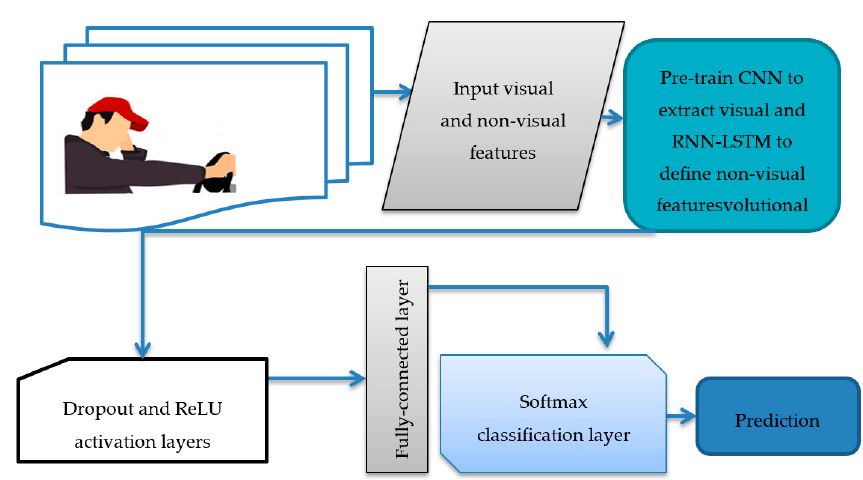
Figure 7. A visual example of multimodal-based features learning for prediction level of driver fatigue on IoT-based plat- form.